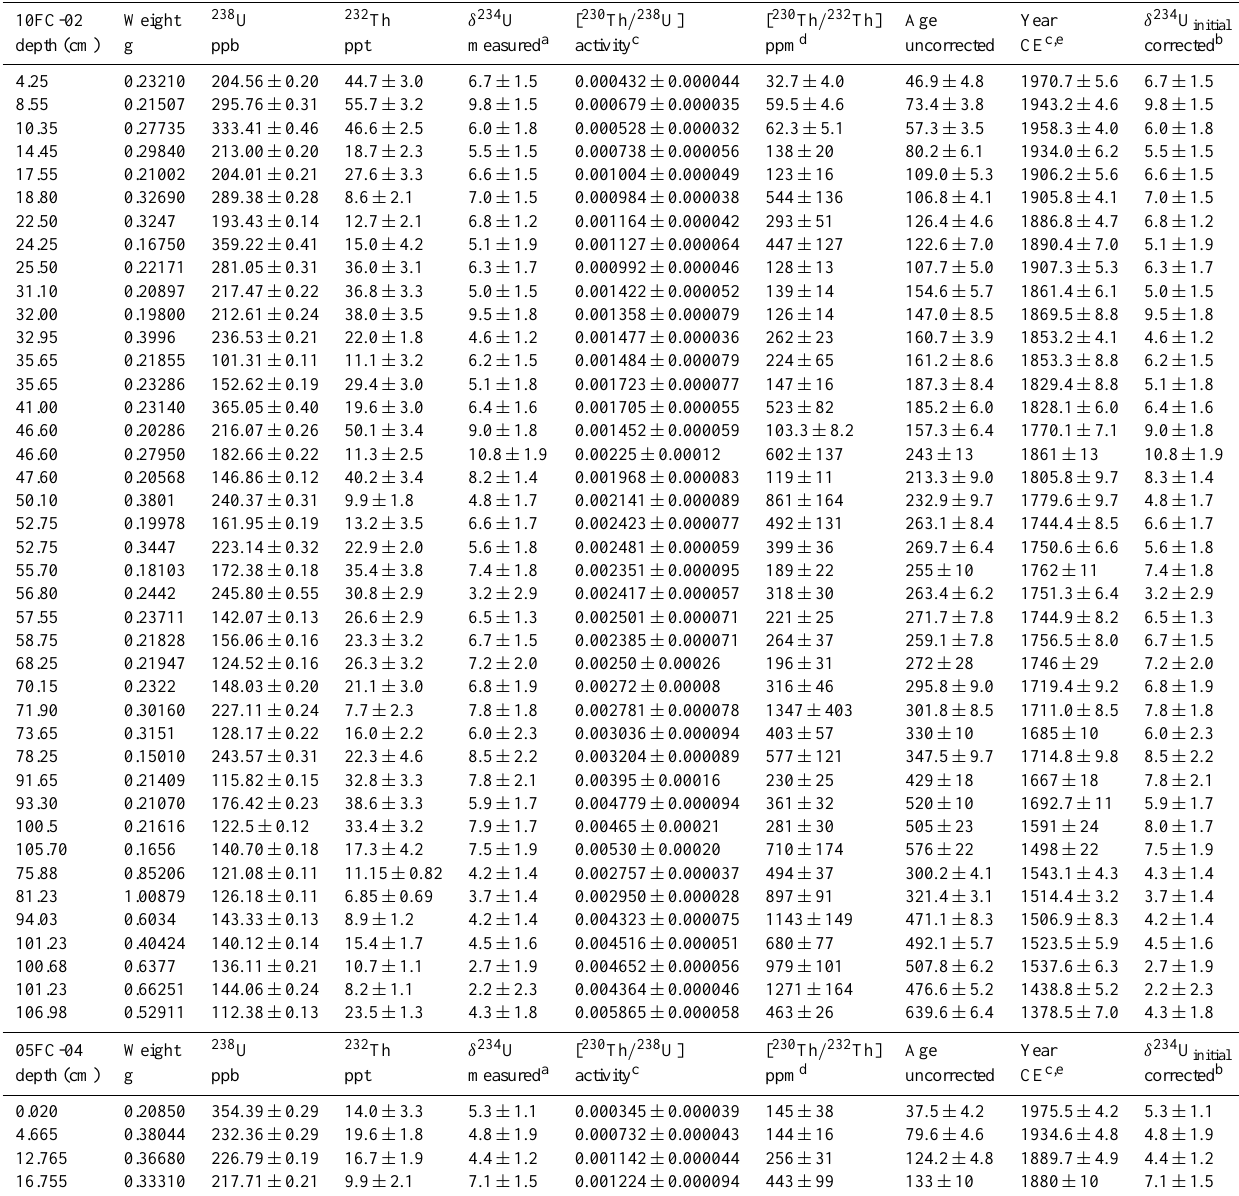
Table 1. U–Th dates used to reconstruct 10FC-02 (top) and 05FC-04 (bottom) stalagmite growth